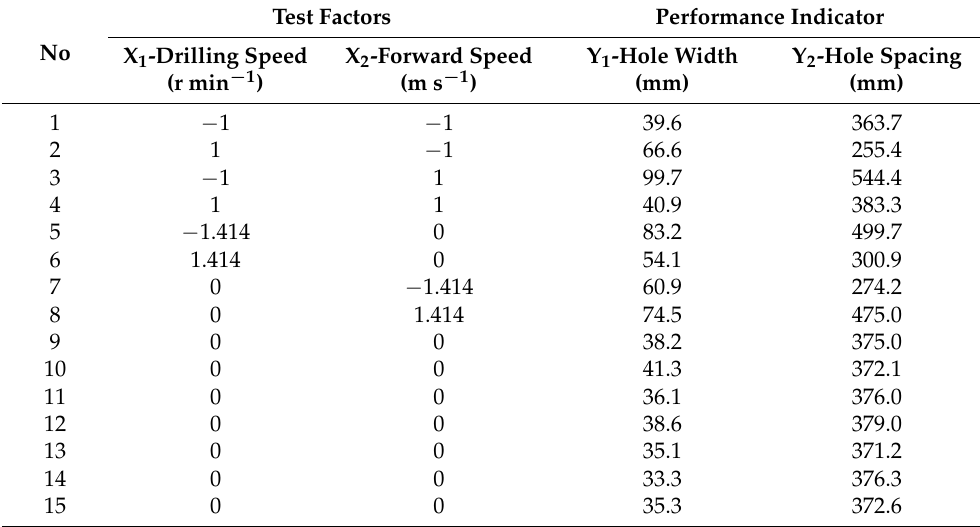
Table 6. Schemes and results of experiment.